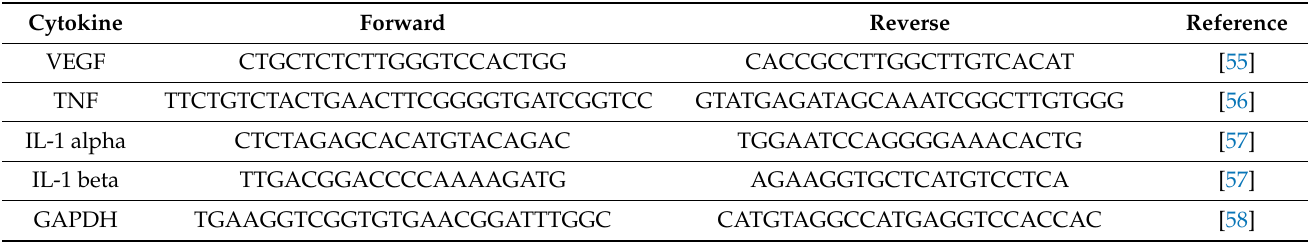
Table 1. Oligonucleotides utilized for semi-quantitative